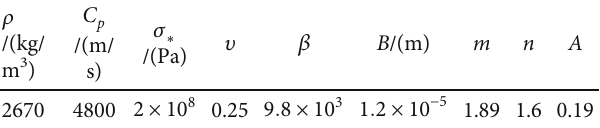
Table 1: The calculation parameters of